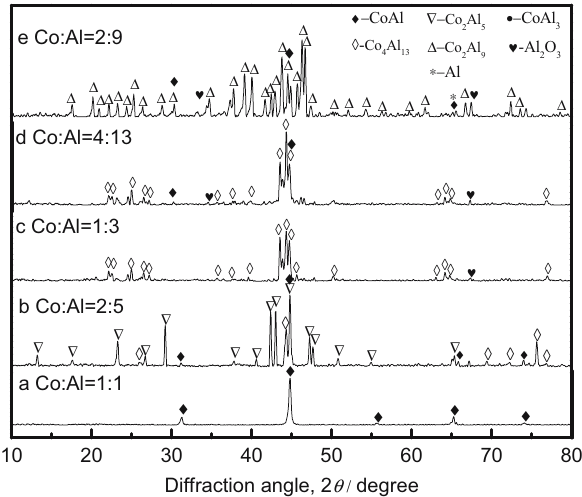
Figure 2: XRD spectra of TE products with different Co/Al